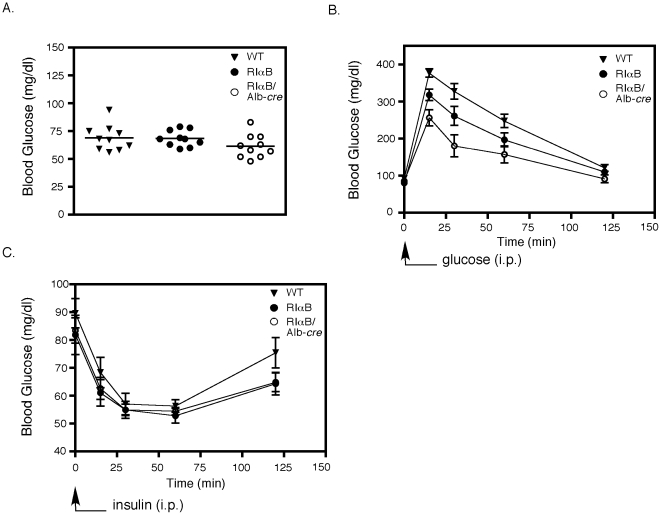
RIαB/Alb-cre mice exhibit increases in glucose disposal.
A, Blood glucose levels were determined in 24 hr fasted WT, RIαB, and RIαB/Alb-cre mice. n = 10. B, Glucose tolerance test was performed in 24 hr fasted WT, RIαB, and RIαB/Alb-cre mice injected i.p. with 2 mg of glucose per gram of body weight. Blood glucose levels were determined at the indicated time points. Over the first 60 min, the glucose disposal of RIαB/Alb-cre was significantly enhanced compared to RIαB alone (p<.001). n = 7. C, WT, RIαB, and RIαB/Alb-cre mice were injected with 0.75 mU of insulin per kilogram of body weight at time 0 and blood glucose levels were determined at the indicated time points. Values are presented as means ± SEM. n = 10.